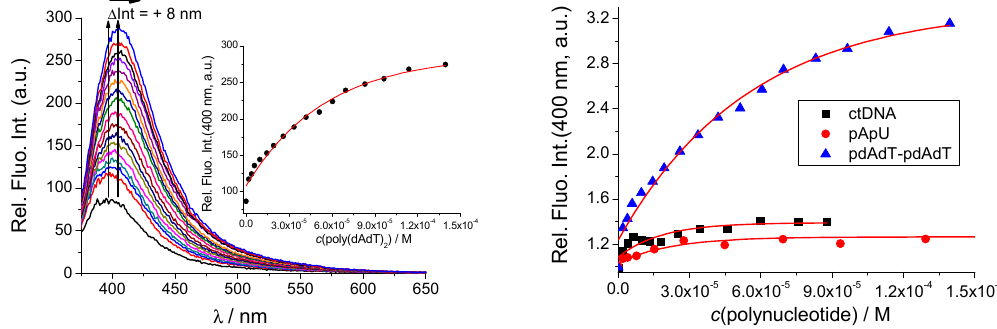
Figure 4. ( Left ): Fluorimetric titration of qAN1-pyr1 ( c = 1 × 10 − 6 M; λ exc = 350 nm) with poly (dAdT) 2 ; ( Right ): titrations with ds-DNA/RNA at 400 nm. Performed in sodium cacodylate buffer (pH 7, I = 0.05 M) at room temperature.